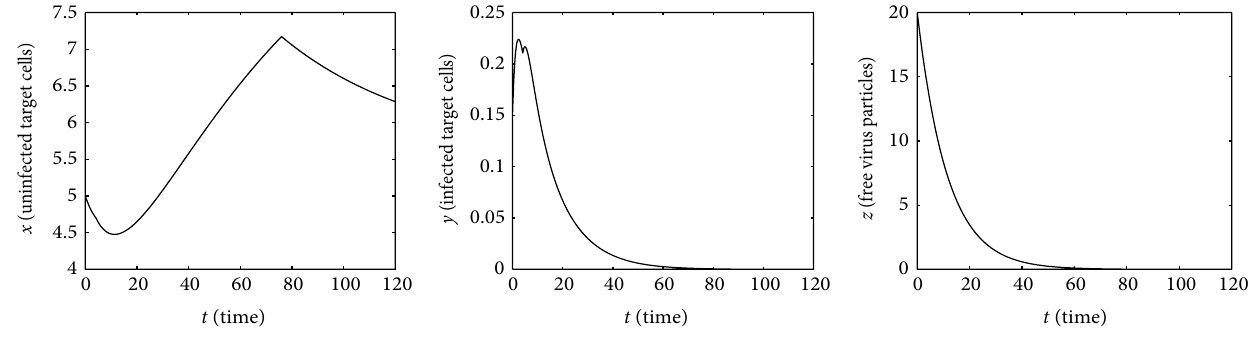
Figure 5: Optimal solutions for 푇 = 120.0 : 푥